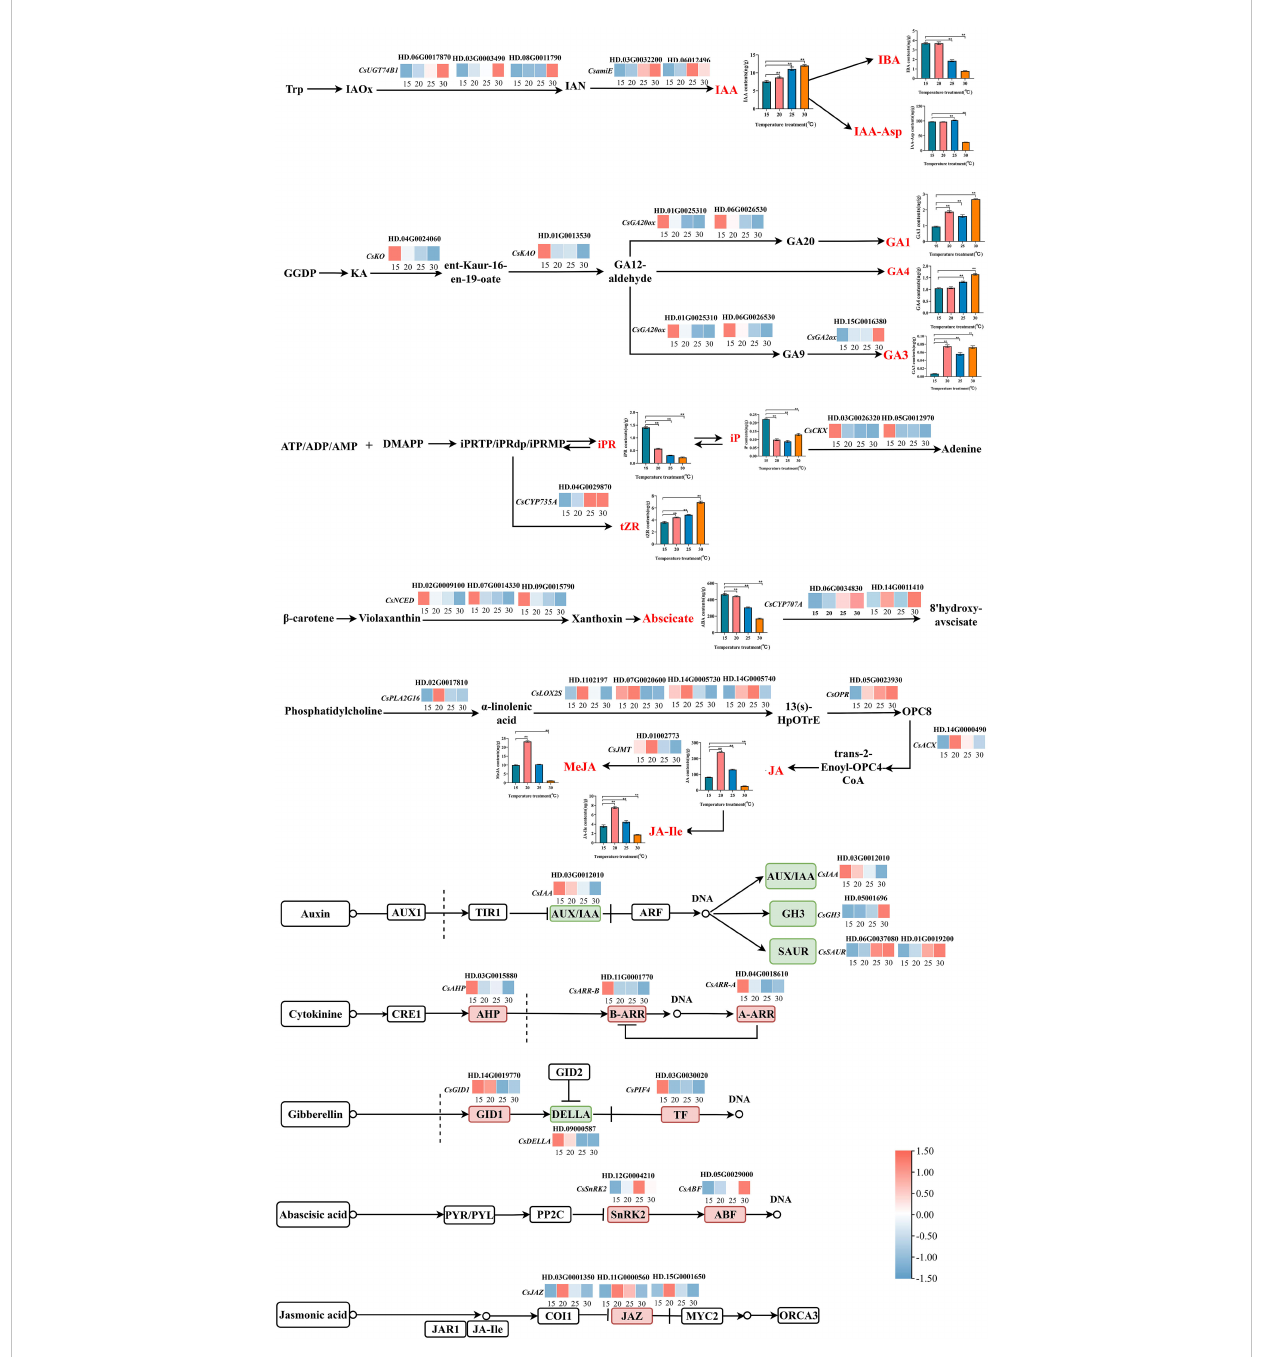
FIGURE 5 The biosynthesis of endogenous hormones in response to temperature in tea plant. * Signi fi cance level 5% (P < 0.05), ** Signi fi cance level 1% (P <